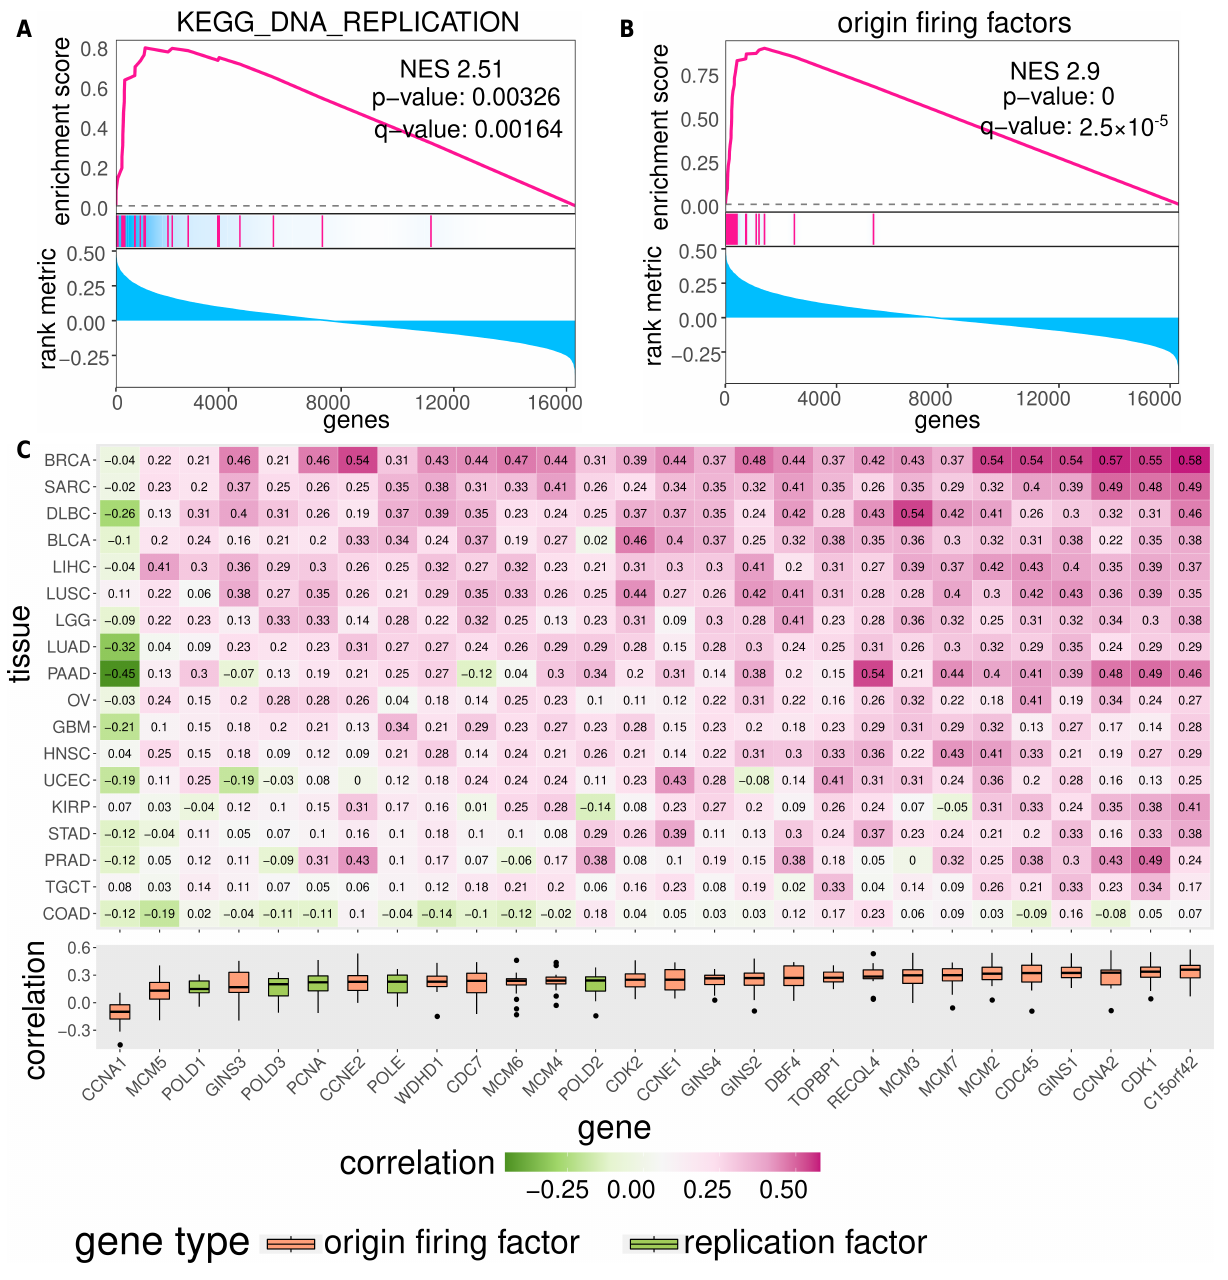
Figure A5. ( A ) Gene set enrichment analysis (GSEA) [67] for KEGG [68] DNA replication gene set. All genes are ordered according to the correlation of their expression with the SCS and enrichment significance is evaluated using permutation test. ( B ) GSEA analysis for manually curated origin firing factor gene set (curated in [10]). ( C ) Gene expression of many origin firing factors is positively correlated with SCS in many cancer types. Rows and columns of the heatmap represent cancer types and origin firing factor genes, respectively. Cancer types are clustered based on their correlation coefficients with origin firing factors. Genes are ordered based on the median correlation coefficient. Colour and values encoded in the heatmap represent the Spearman correlation